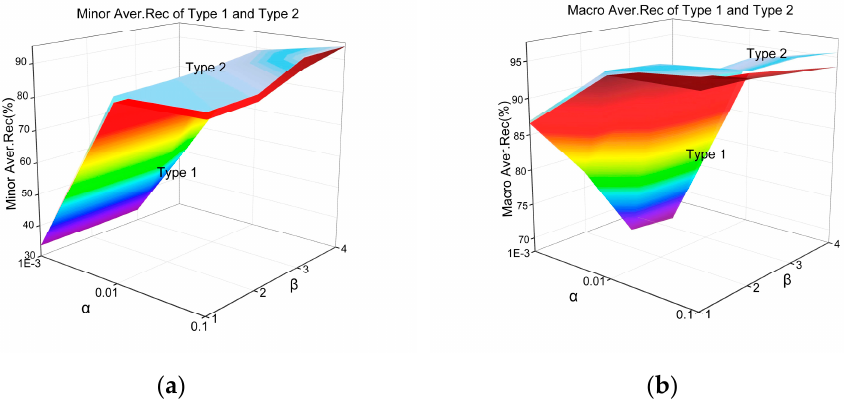
Figure 9. Classification performance comparison of Type 1 and Type 2 on CICIDS 2017 dataset. ( a ) Minor Aver.Rec; (b) Macro Aver.Rec